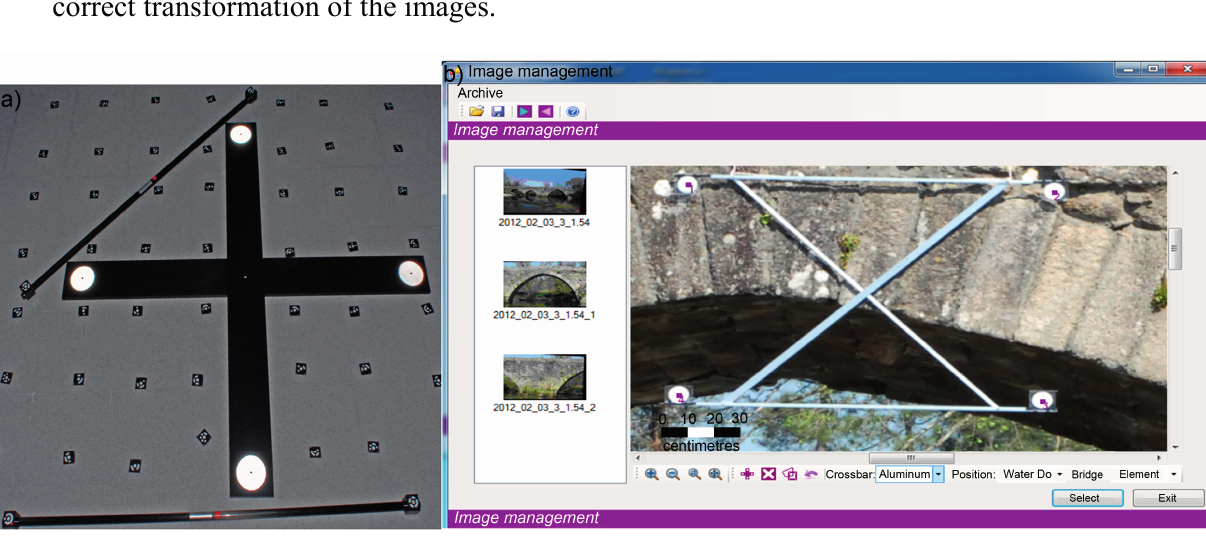
Figure 1. Image of auxiliary tools for the rectification of images at the time of ( a ) calibration at the laboratory and ( b ) in situ measurements. The 2D position of the center of the round white targets is measured with great precision, thereby guaranteeing the correct transformation of the